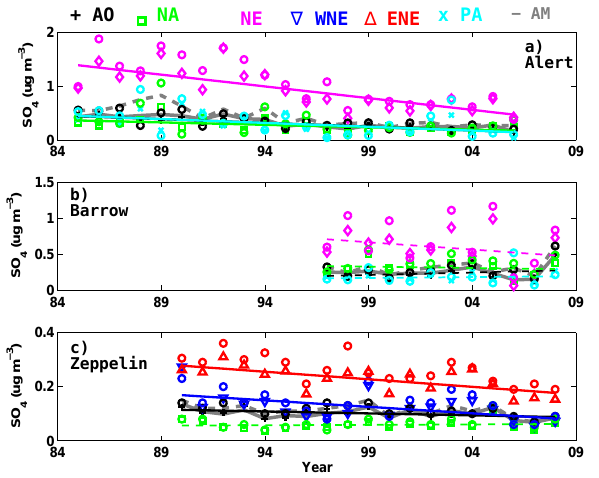
Fig. 15. Annual geometrical means and medians of the sulphate concentrations for all measurements (solid gray and dashed gray re- spectively) and for the four different clusters at Alert (a) , Barrow (b) , and Zeppelin (c) . Medians are marked with circles and geo- metric means with unique symbols according to the legend at the top. Trend lines calculated from the geometrical mean values are shown with solid lines for trends with a statistical significance on the 90% confidence level, other trends are shown with dashed lines.